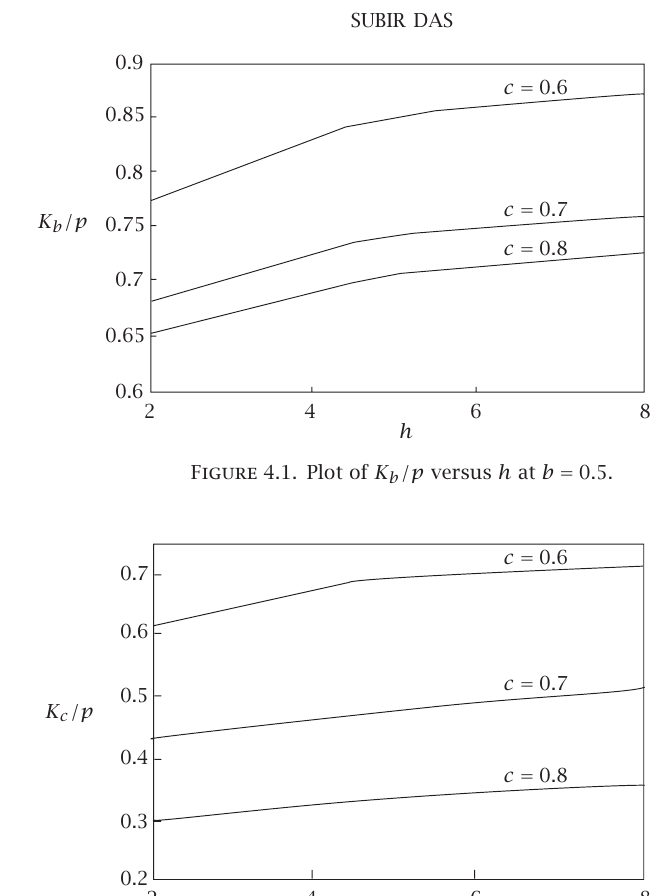
Figure 4.2 . Plot of K c /p versus h at b = 0 . 5.